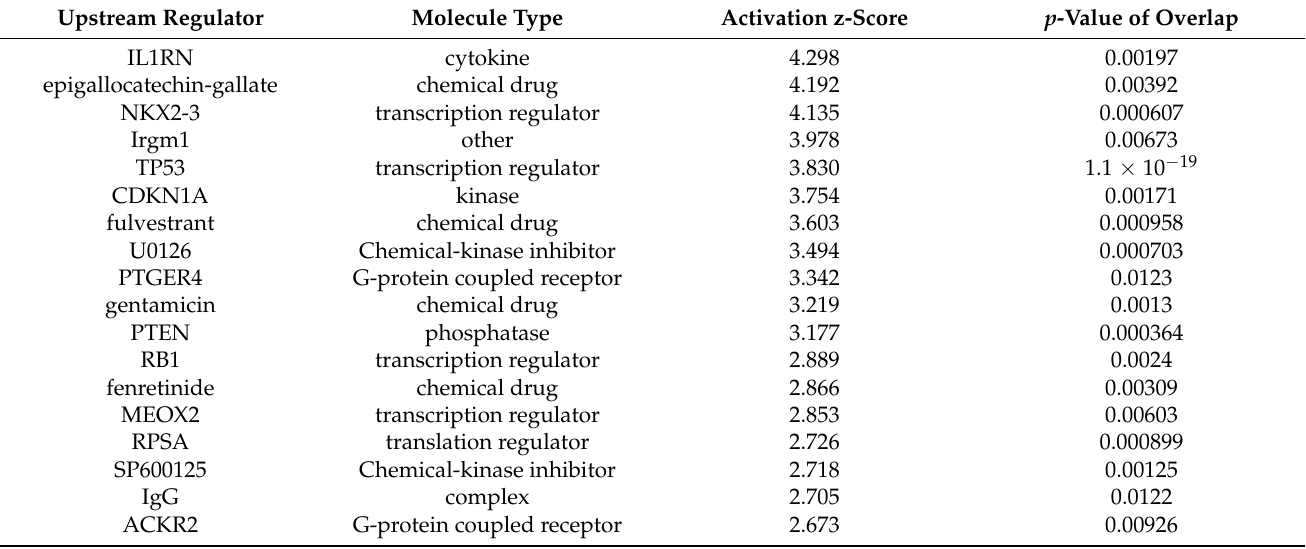
Table 1. The top 20 activated upstream regulators predicted by